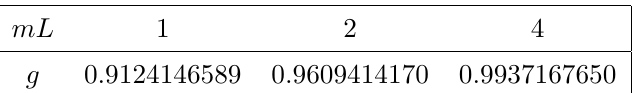
Table 2 . A few examples of the g -function for a choice of the boundary parameters ( (cid:17) = (cid:25)= 2 and # = 0) and for di(cid:11)erent values of the sinh-Gordon mass and radius. The sum (3.1) was truncated to 10 terms. We only show the signi(cid:12)cant digits, but one can straightforwardly increase the